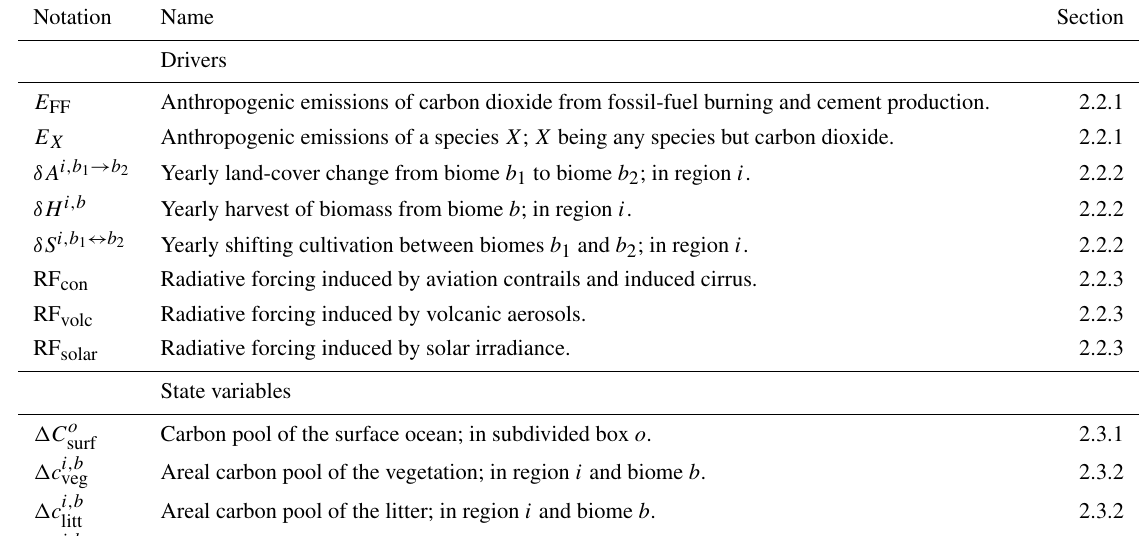
Table 1. List of drivers and state variables of the